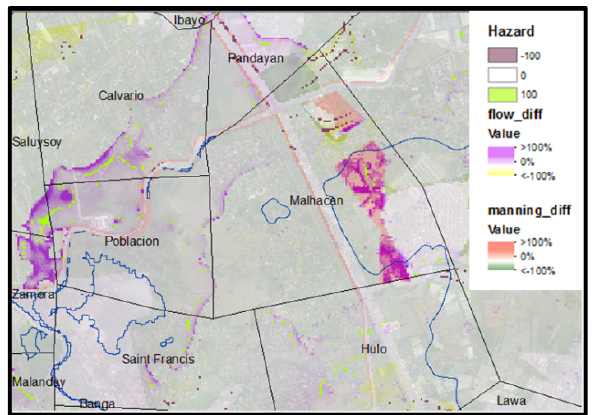
Figure 10. Change in Flooding due to Land Use change in Area 3.3.2